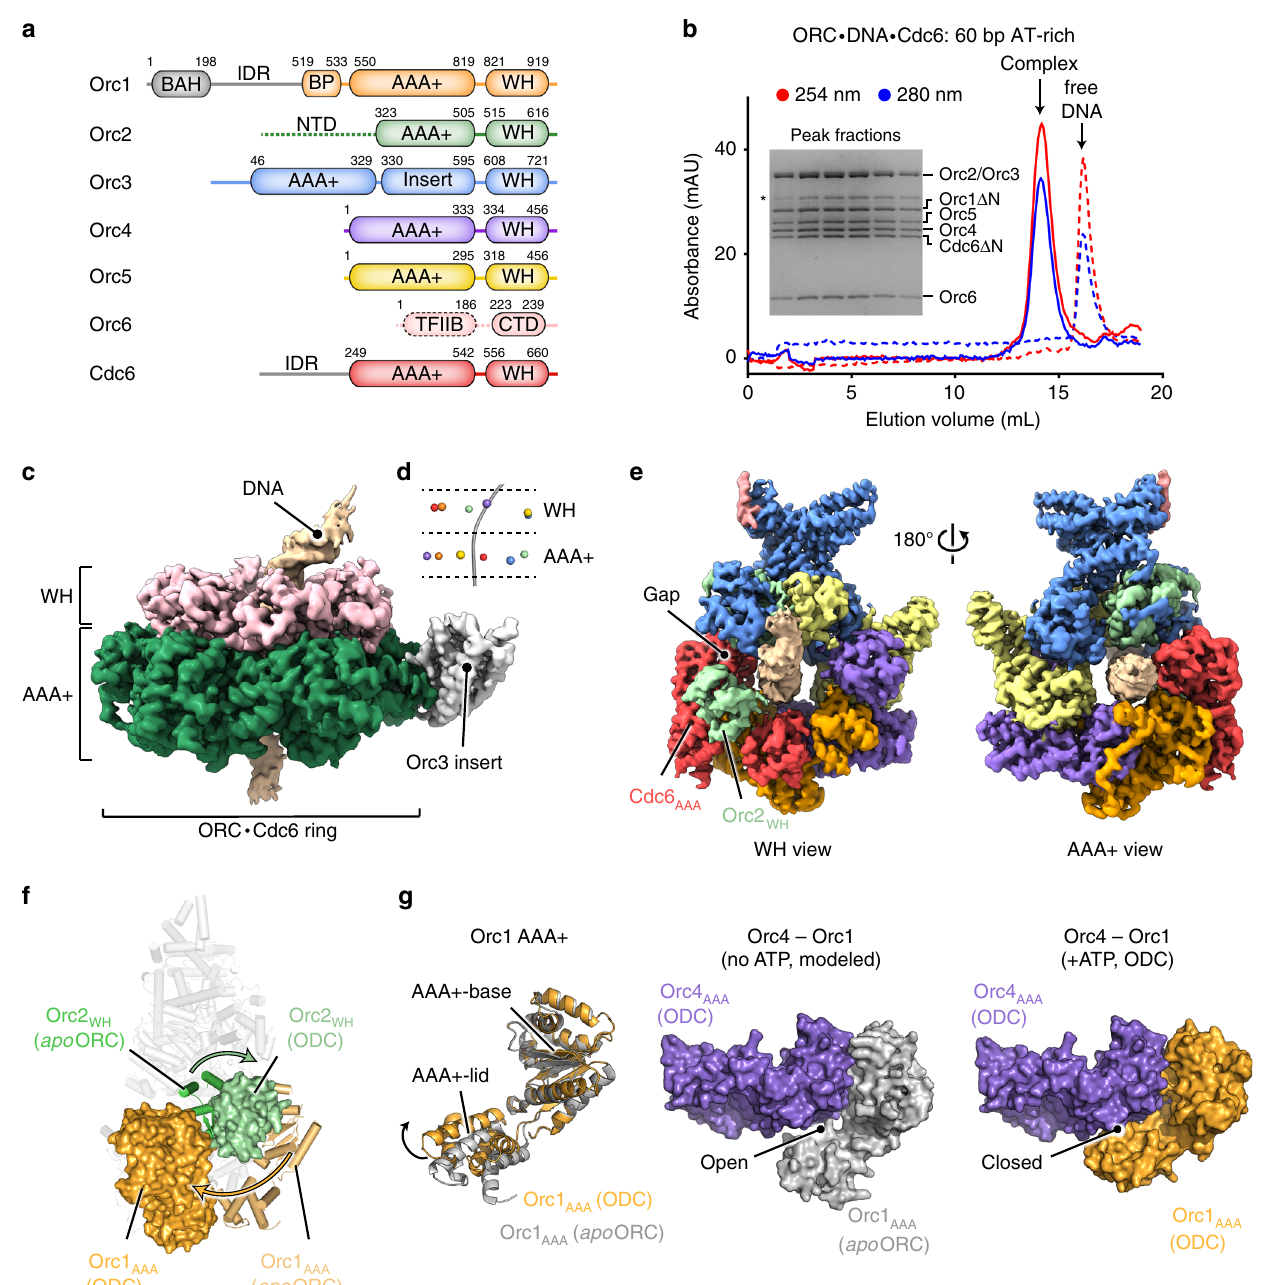
Fig. 2 Structure of a licensing-competent Dm ORC·DNA·Cdc6 complex. a Domain architecture of Dm ORC subunits and Cdc6. Dashed lines demarcate regions that are fl exible and structurally not resolved. Gray regions in Orc1 and Cdc6 were removed to improve sample behavior for cryo-EM. The color scheme is maintained throughout the fi gures unless noted otherwise. b Puri fi cation of Dm ORC·DNA·Cdc6 for cryo-EM. Chromatograms are shown for the ternary complex (solid lines) and for isolated DNA (dashed lines). Peak fractions retain all Dm ORC subunits and Dm Cdc6 when analyzed by SDS-PAGE (inset). The asterisk corresponds to a degradation product of Orc2 and/or Orc3. c Side view of the unsharpened cryo-EM map with AAA + and WH domains colored differentially, highlighting the two-tiered organization of the complex. d Near-planar arrangement of the AAA + and WH modules with respect to the main DNA axis (gray line) in the ORC·Cdc6 ring. The centers of mass of the AAA + base and WH domains are depicted as spheres. e AAA + and WH view of the cryo-EM density (unsharpened) with ORC and Cdc6 subunits colored differentially. The gap between Orc3 and Orc2 in the WH layer is indicated. f , g Conformational rearrangements in Dm ORC during the transition from the autoinhibited to the activated state. In f the positions of the Orc1 AAA + and Orc2 WH domains in the autoinhibited apo - Dm ORC state (shown as cartoon; PDB 4xgc 16 ) and the ORC·DNA·Cdc6 complex (ODC; depicted as molecular surface) are compared after structural alignment of both assemblies. Arrows indicate the domain movements during activation. Side views are shown, and other subunits/domains are displayed as light gray cartoon. g ATP binding to Orc1 reorients the Orc1 AAA + -lid and closes the Orc1/ 4 interface. The Orc1 AAA + -base subdomain of Orc1 in apo-Dm ORC (PDB 4xgc 16 ) was superposed on the same region in the ternary complex. BAH, bromo-adjacent homology domain; IDR, intrinsically disordered region; BP, basic patch; WH, winged-helix; NTD, N-terminal domain; CTD, C-terminal domain; TFIIB, transcription factor IIB-like domain. Source data are provided as a Source data fi